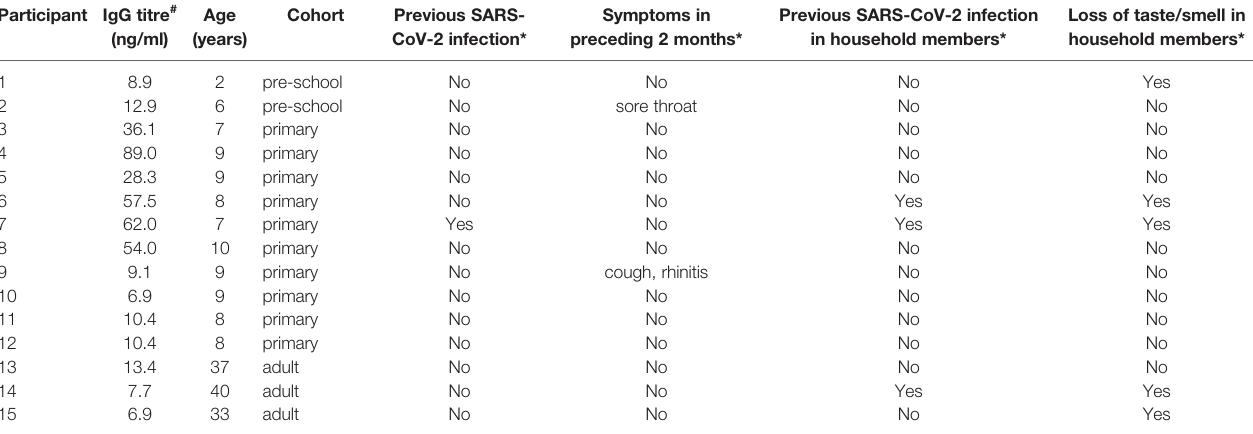
TABLE 5 | Characteristics of salivary SARS-CoV-2 IgG positive individuals. Age Participant IgG titre # (ng/ml)